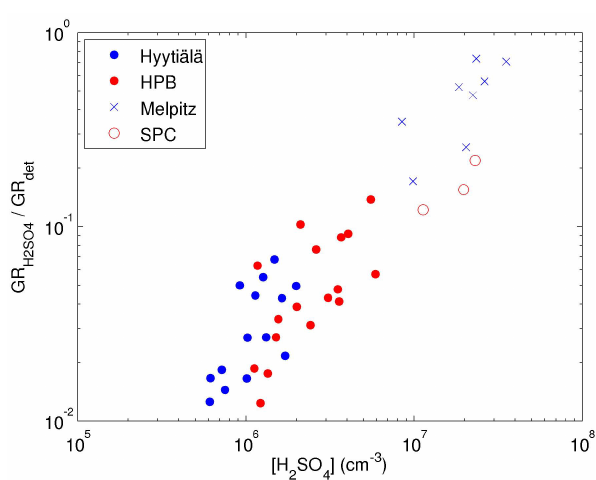
Fig. 3. The ratio between calculated growth rate due to sulphuric acid condensation and the growth rate determined from particle size distributions, as a function of sulphuric acid concentration at four measurement